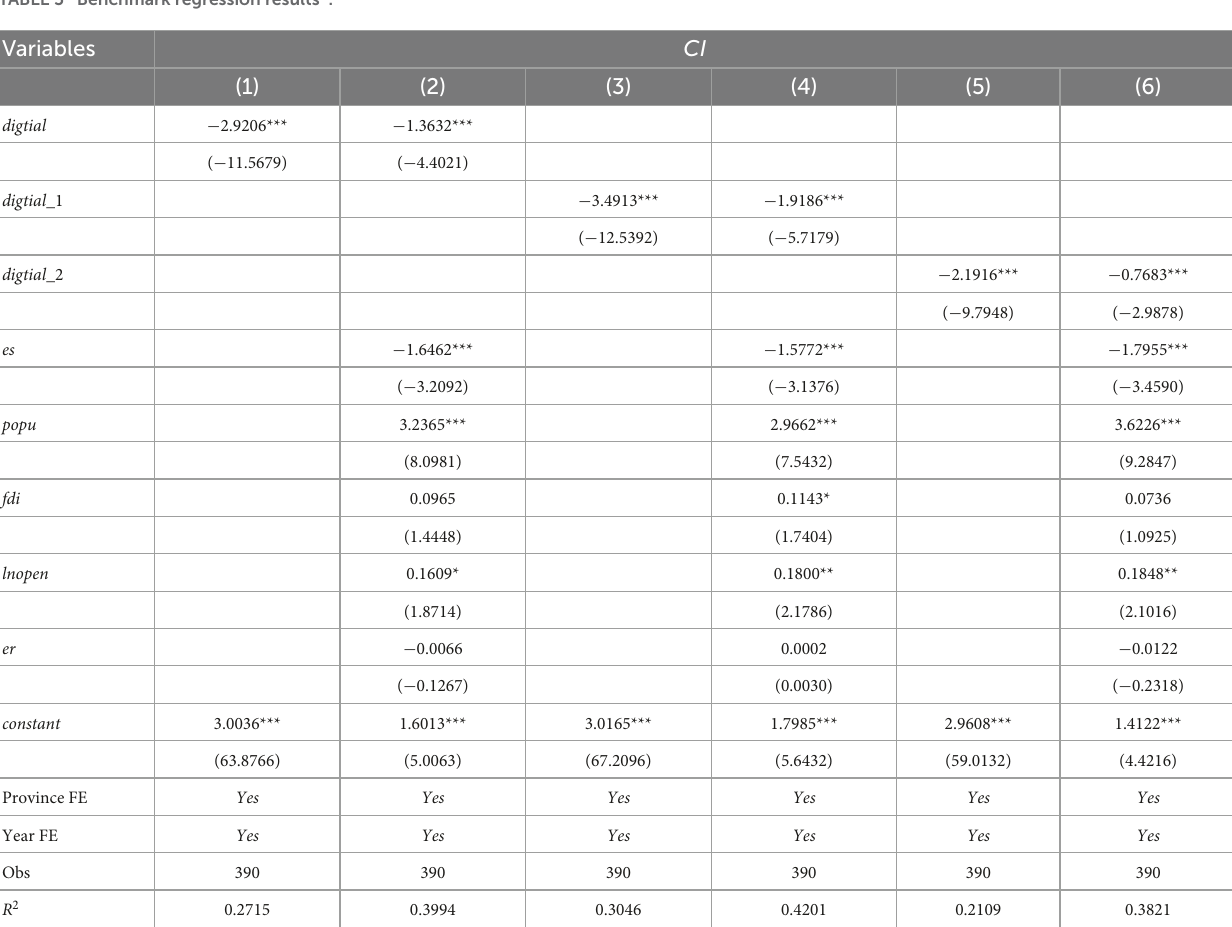
TABLE 5 Benchmark regression results a